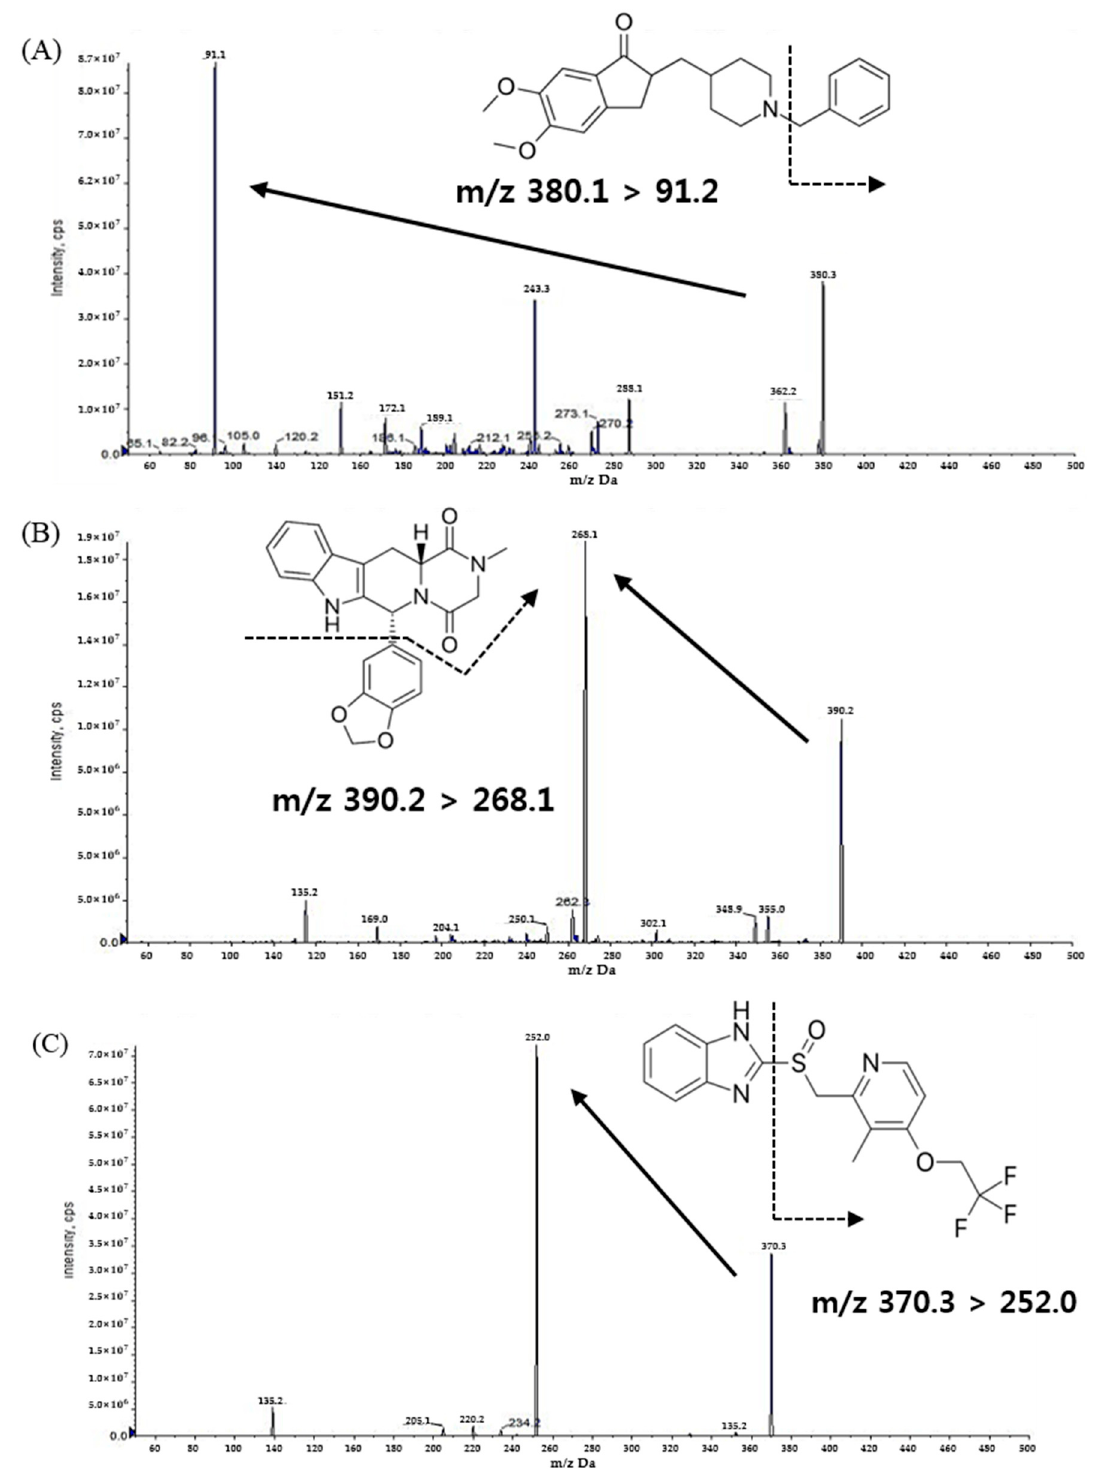
Figure 1. Product ion mass spectra and the pattern of fragmentation of ( A ) donepezil, ( B ) tadalafil, and ( C )